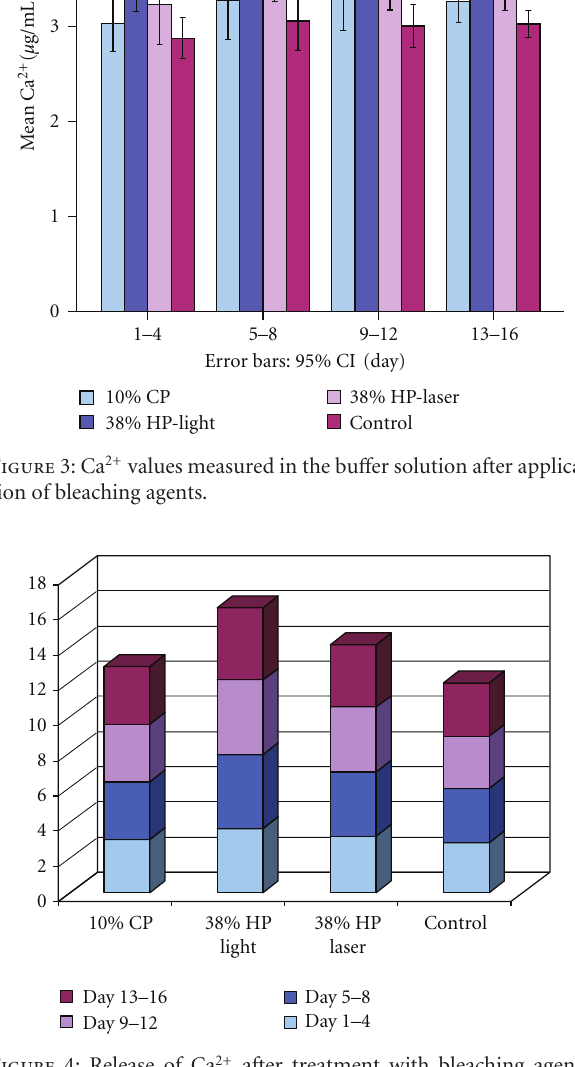
Figure 4: Release of Ca 2+ after treatment with bleaching agents (permm 2 , measured